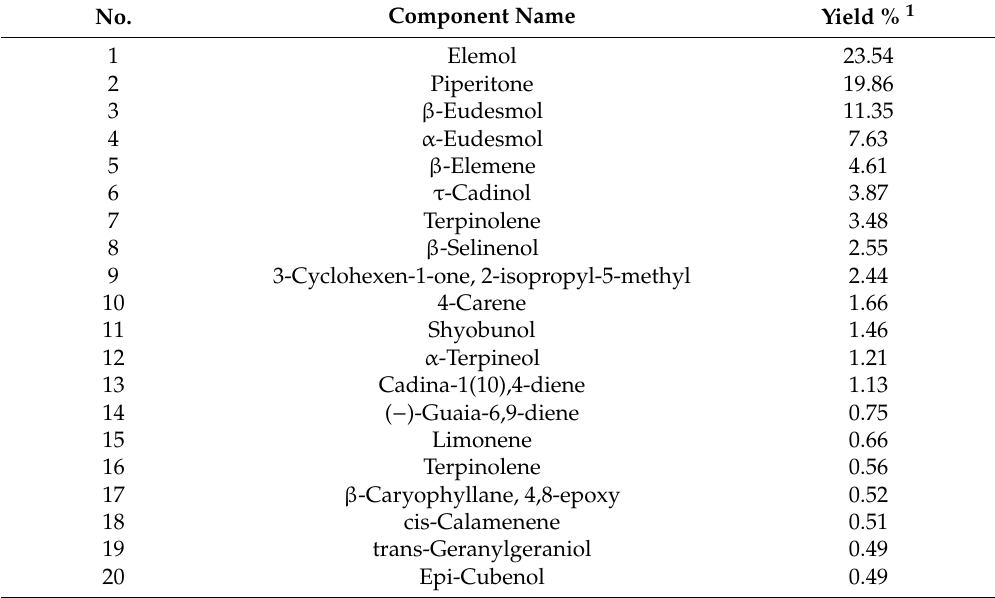
Table 1. Components of Cymbopogon proximus essential